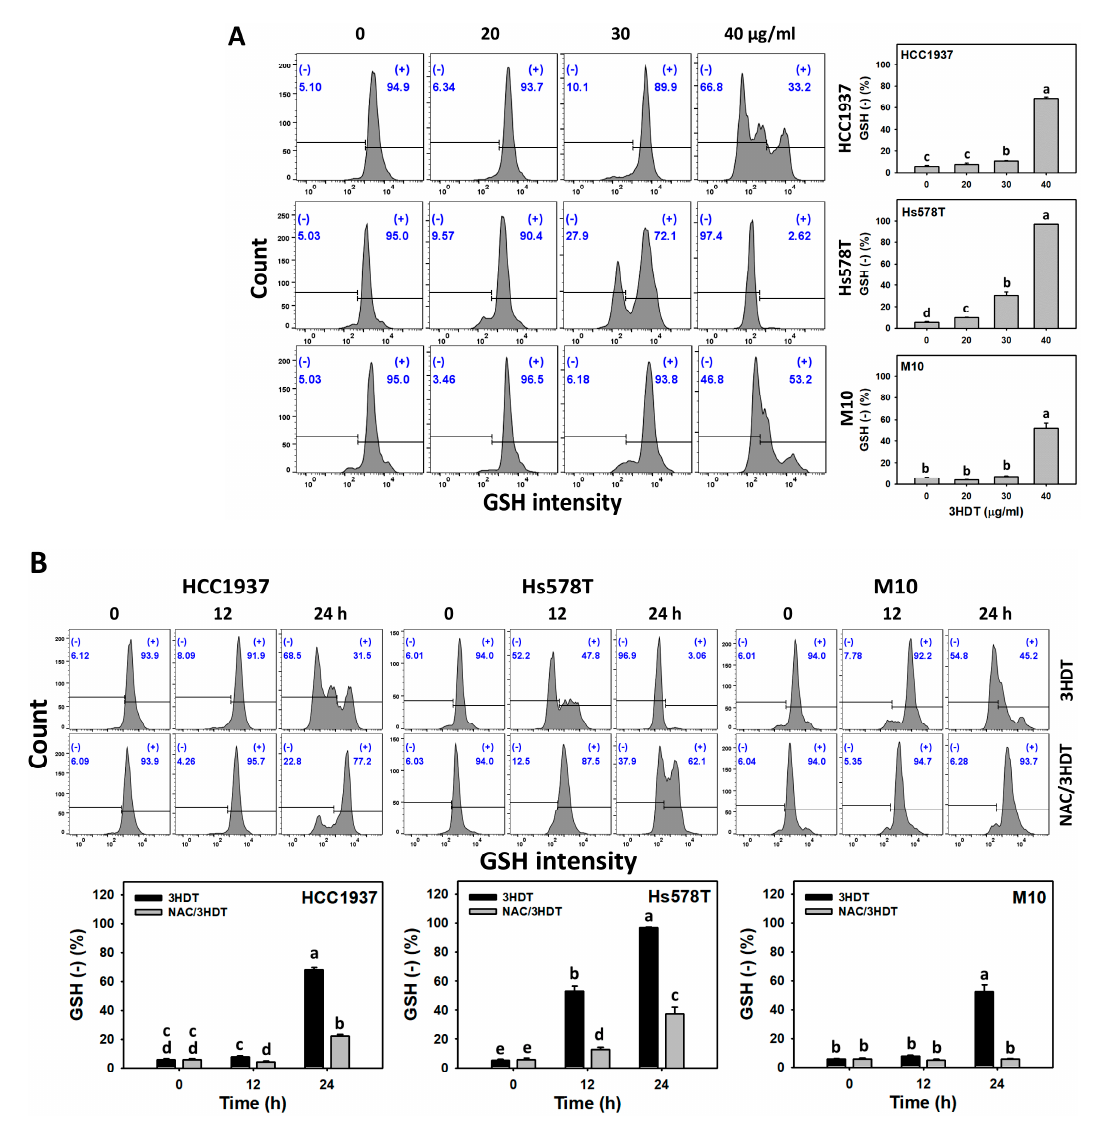
Figure 7. GSH status of 3HDT treatment. ( A ) GSH flow cytometry assay of 3HDT for 24 h. ( B ) GSH flow cytometry assay of NAC/3HDT. 3HDT and NAC/3HDT indicate 12 or 24 h 3HDT treatment (40 μ g/mL) without and with NAC pretreatment, respectively. ( − ) is marked as GSH ( − ), which indicates the proportion with low GSH level, while (+) indicates the proportion with high GSH level. Data: mean ± SD ( n = 3). Treatments differ significantly for multiple comparisons when the letters are not overlapping ( p < 0.05).